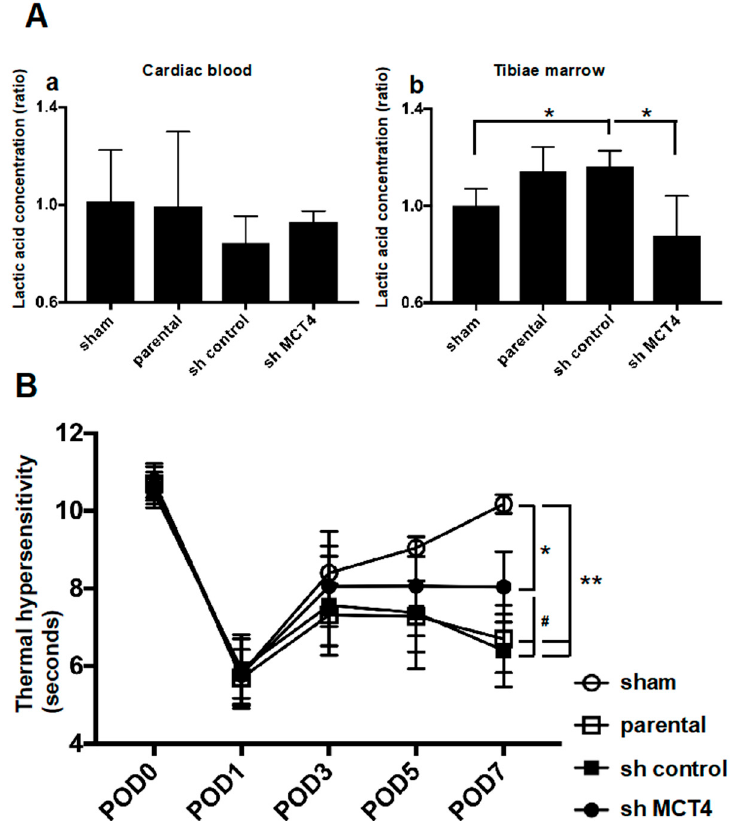
Figure 5. Bone pain and lactate concentration in sham mice and SAS cell-injected mice. ( A ) Lactate concentration in cardiac blood sampling or tibiae marrow ( n = 5). ( a ) Lactic acid concentration in cardiac blood. ( b ) Lactic acid concentration in tibial bone marrow. Error bars: mean ± SD. * = p < 0.05 vs. sh-control. ( B ) Thermal sensitivity results of each group. The test was performed every other day from POD one to seven ( n = 5). Error bars: mean ± SD. * = p < 0.05 vs. sham; ** = p < 0.01 vs. sham; # = p < 0.05 vs. sh-MCT4.